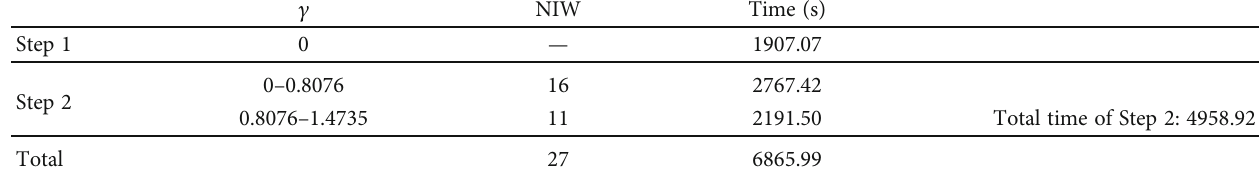
Figure 6: The contours of the ground state density function j ϕ j 2 of (15), where V ffiffiffi p ε = 1/ 5 , ω = 1 : 7 , β = 500 , and λ = γβ . Table 3: The execution time (in seconds) for computing the ground state solution of Example 5(2) by implementing Algorithm 2. NIW: number of iterations in the while loop of Step 2.